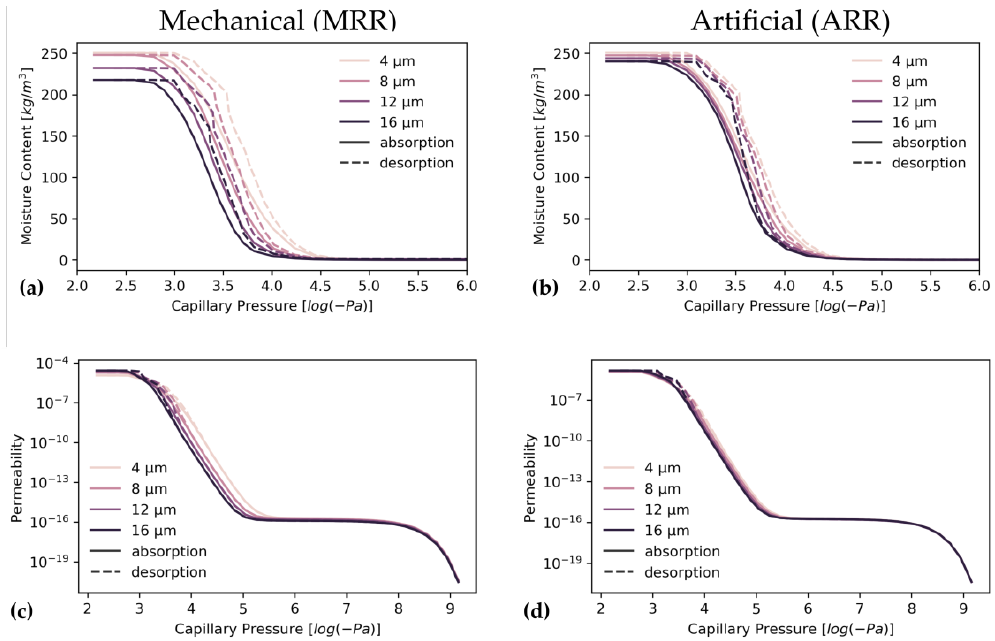
Figure 9. Resolution influence on unsaturated moisture absorption and desorption or drying ( a , b ) and moisture permeability ( c , d ) with changing capillary pressure. Absorption would increase capillary pressure because this pressure is linked to relative humidity thus following the graphs from right to left. Desorption or drying follows the opposite direction. The di ff erence between the solid and dotted line shows ”hysteresis”. Only data from first volume (V1) is shown. Note that a and b have their x-axes cropped to represent a narrower capillary pressure range than moisture permeability ( c , d ), because no visible moisture variation occurs in the higher log(-Pa) range. In samples obtained through Mechanical Resolution Reduction (MRR), the spread on the onset of moisture increase ( a ) and permeability increase ( c ) is higher than for samples obtained from Artificial Resolution Reduction (ARR), as seen for moisture uptake ( b ) and permeability increase ( d ).